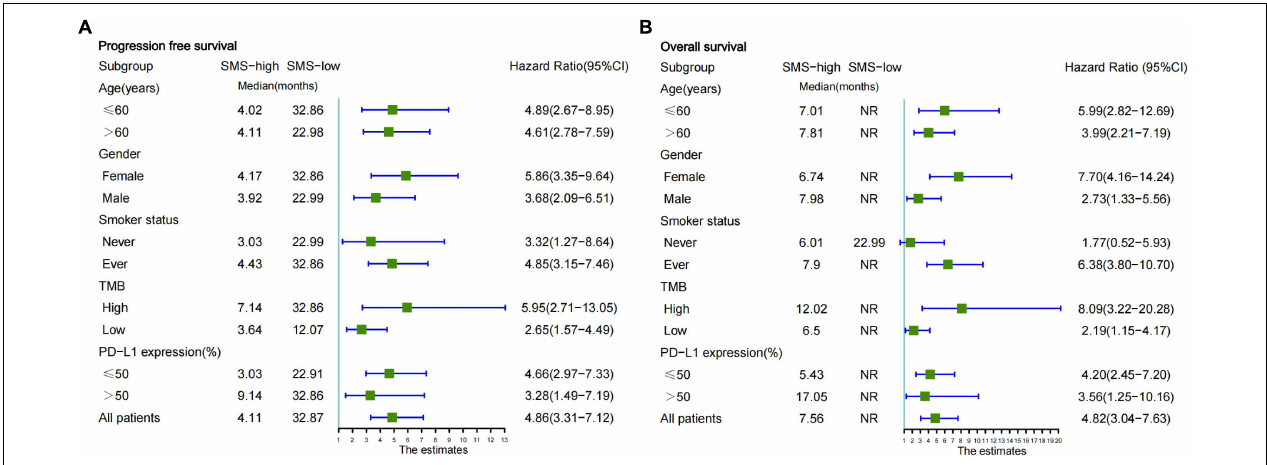
FIGURE 4 | Subgroup analysis of the SMS for PFS and OS from the combination cohort according to basic clinical variables. (A) Forestplot of the SMS for PFS is presented in the combination cohort. (B) Forestplot of the SMS for OS is presented in the combination cohort. Each subgroup HR is computed from univariate analysis. Fixed-effects model is used to calculate pooled HRs for each subgroup. The bars indicate 95% CI. SMS, somatic mutation signature; PFS, progression-free survival; OS, overall survival; NR, not reached; PD-L1, programmed cell death-ligand 1; HR, hazard ratio; CI, confidence